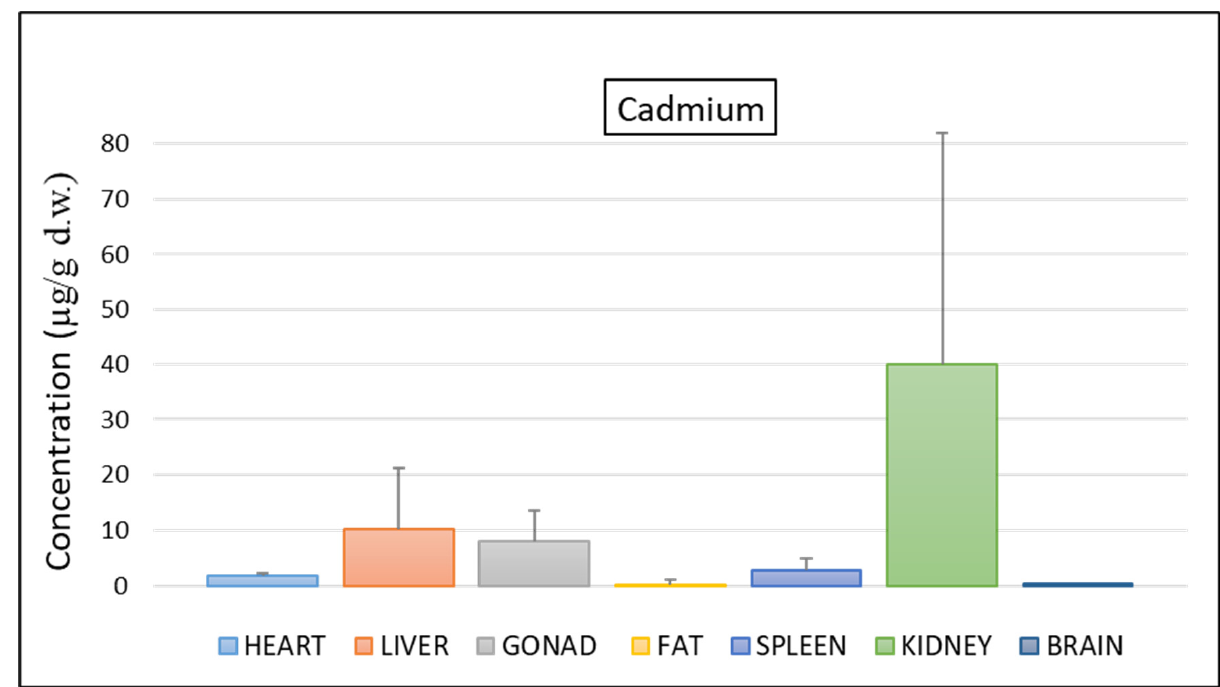
Figure 2. Mean concentration ± SD of cadmium in the tissues of nine individuals of C. caretta.